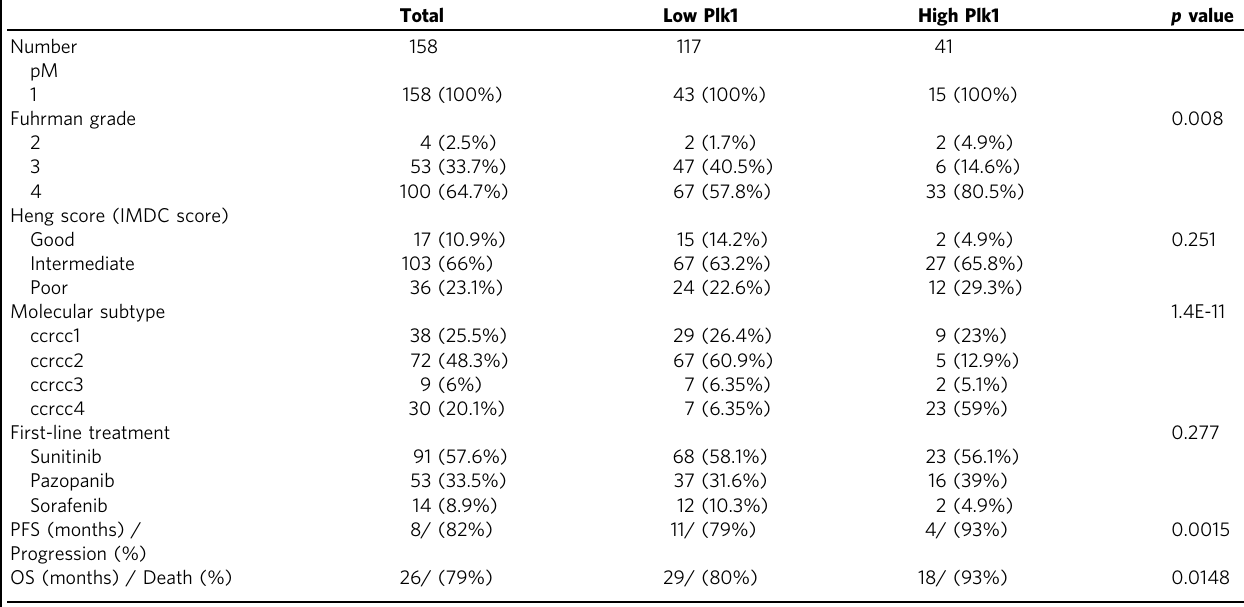
Table 3 The characteristics of the metastatic ccRCC patients included in the